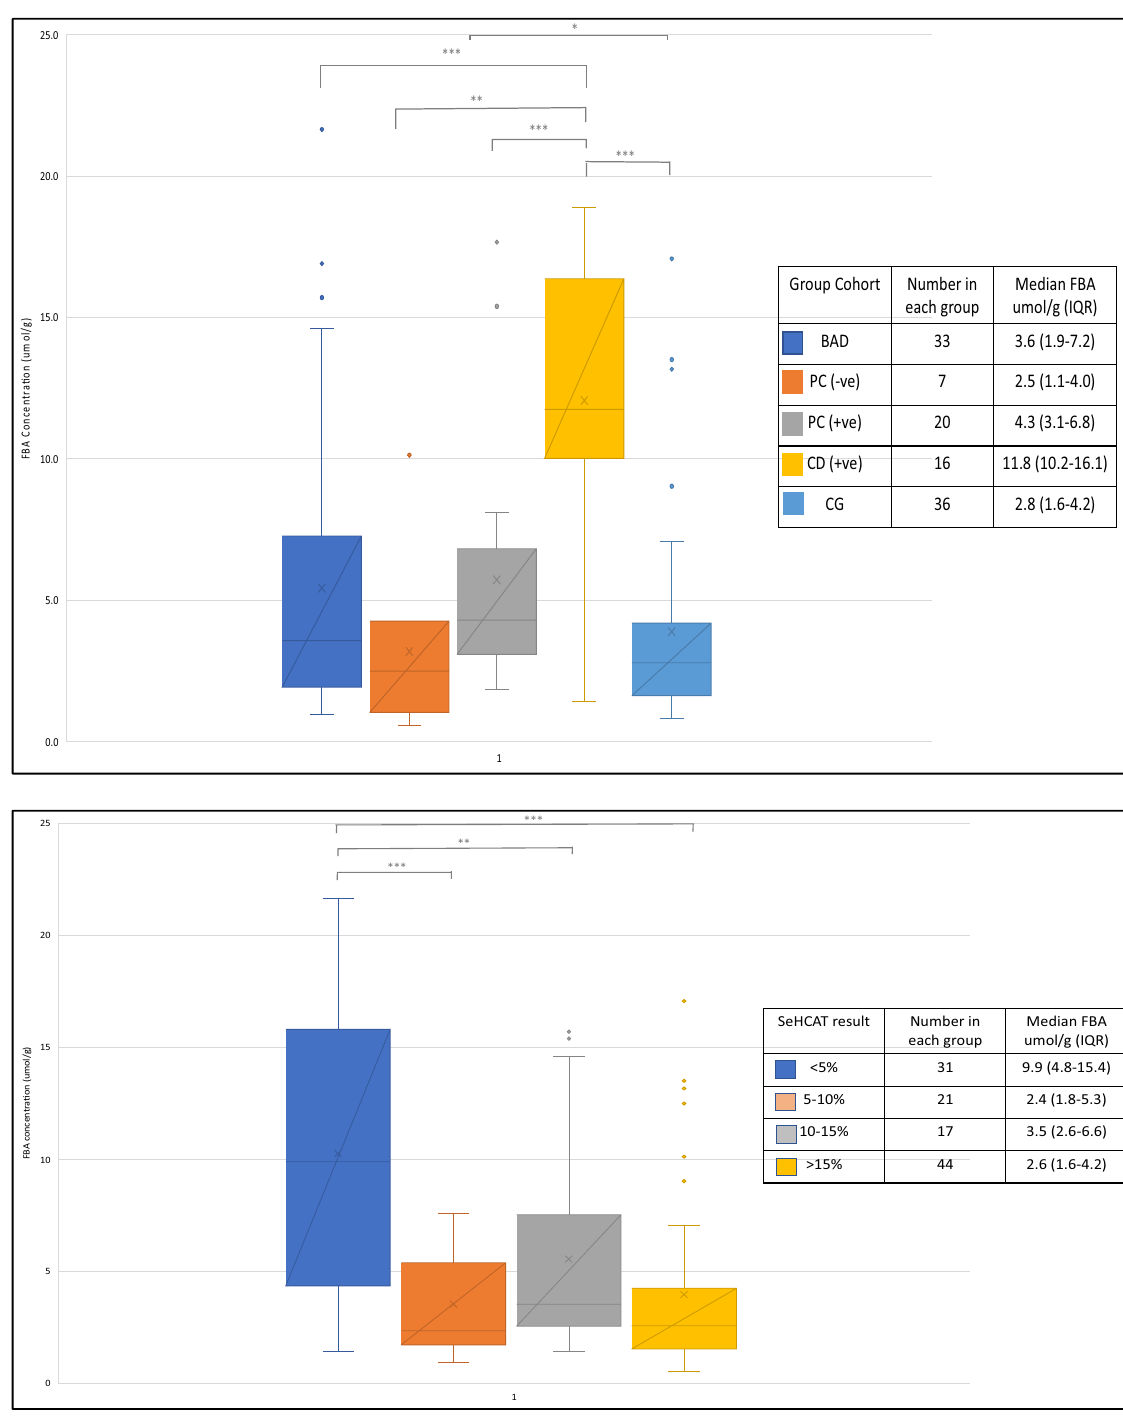
Figure 2. ( a ) FBA concentration in stool samples collected on enrolment to the study in the 4 different study groups— FBA faecal bile acids, BAD bile acid diarrhoea, CD +ve Crohn’s disease patients with a positive SeHCAT scan, PC +ve post-cholecystectomy patients with a positive SeHCAT scan, PC − ve post- cholecystectomy patients with a negative SeHCAT scan, CG SeHCAT-negative control group. The total number of patients and the median and interquartile range (IQR)s from each cohort are also listed. ( b ) Faecal bile acid (FBA) concentration in stool samples collected on enrolment to the study split into SeHCAT result where < 5% indicates severe BAD, 5–10% moderate, 10–15% mild and > 15% as normal result. The total number of patients and median and interquartile ranges (IQR) from each group are also listed. *p < 0.05, **p < 0.01 and ***p <